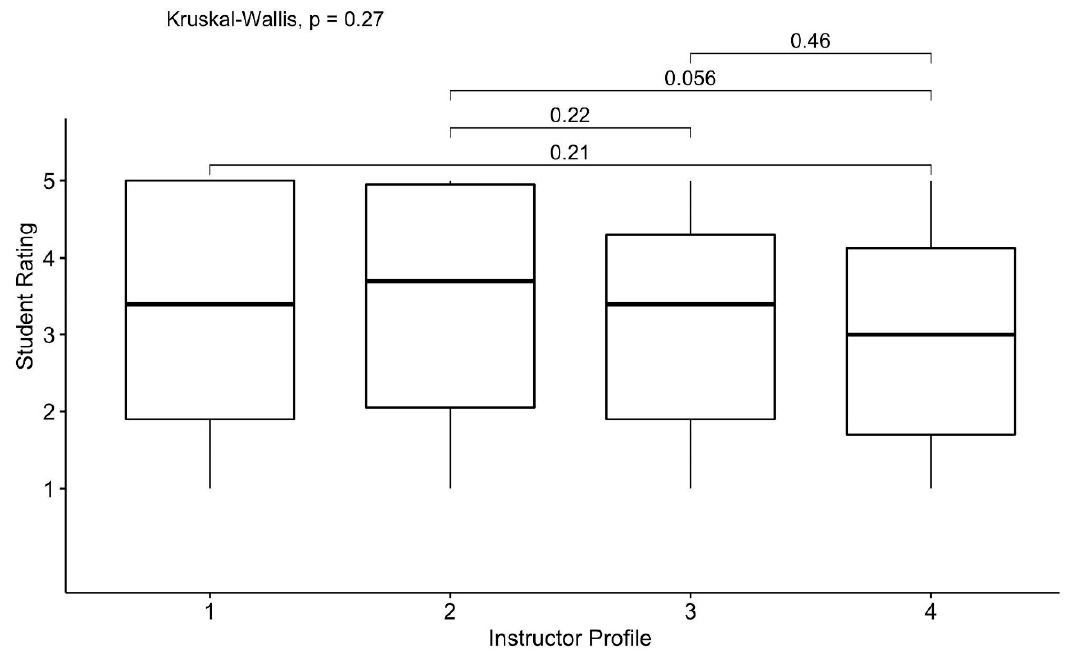
Figure 7. Ratings according to Online Spanish course type and instructor profile. Instructor 1 is a native speaker from Spain, Instructor 2 is a native speaker from Latin America, Instructor 3 is a Heritage Speaker of Spanish, and Instructor 4 is an L2 Spanish speaker.